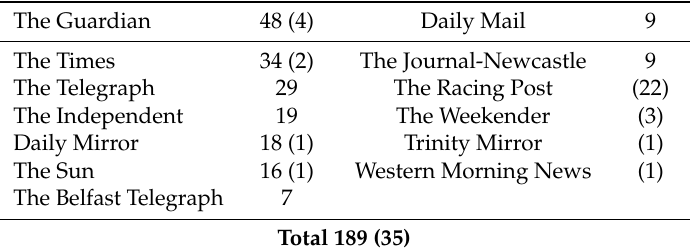
Table 1. UK print media: 2011–2012 (and 2014–2015 in